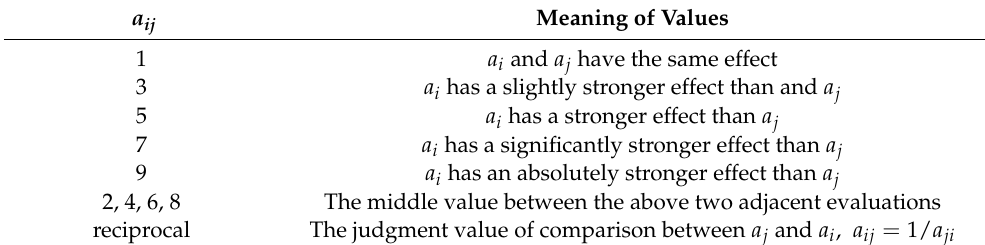
Table 4. 9-point scale